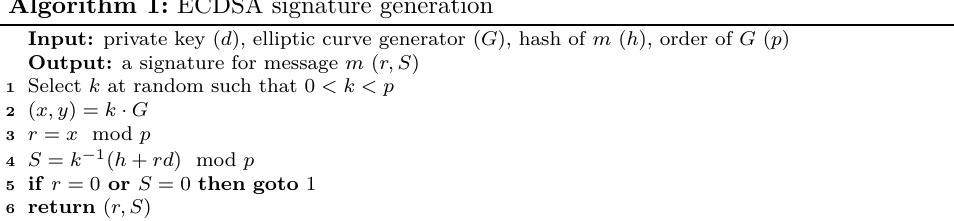
Algorithm 1: ECDSA signature